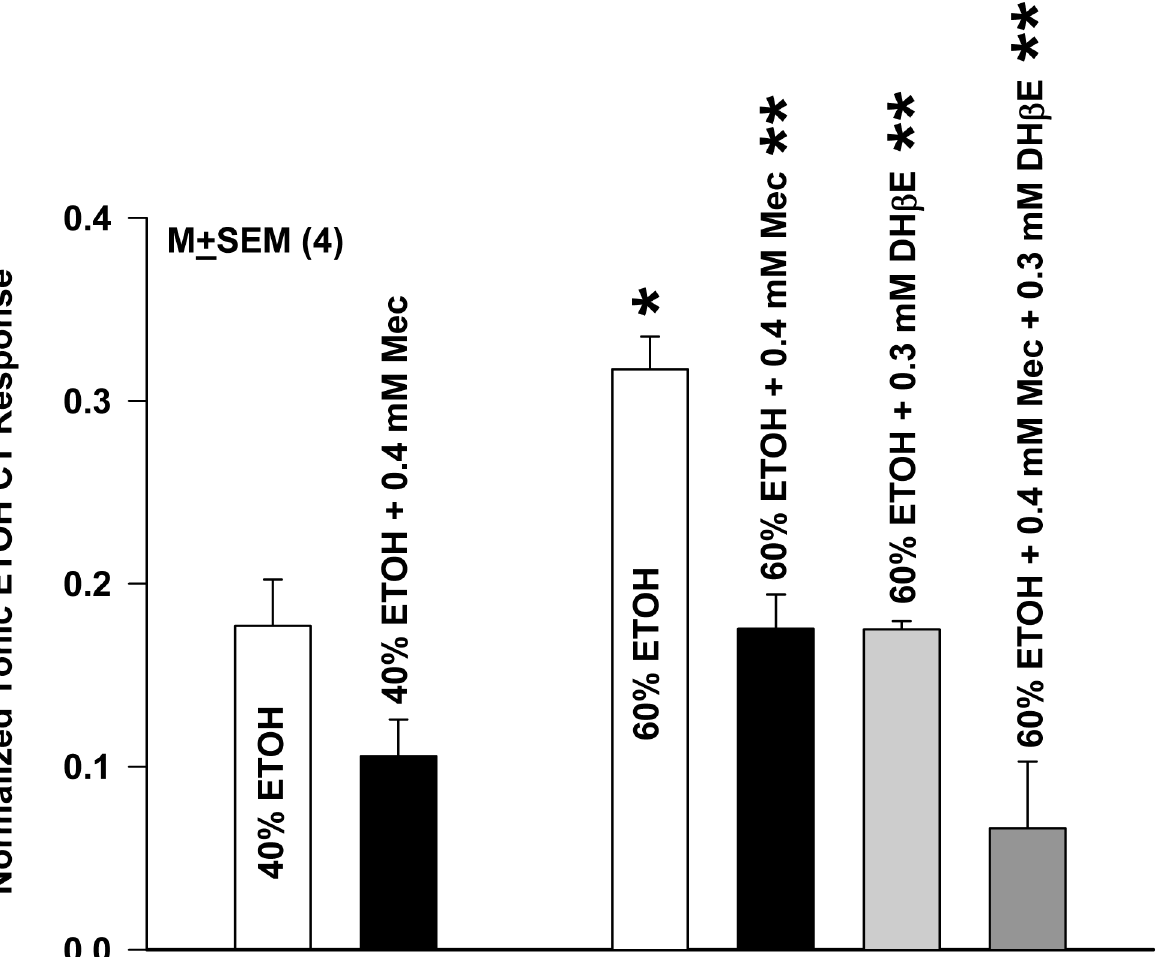
Fig 5. Effect of Mec and DH β E on the rat CT responses to ethanol (ETOH). The mean normalized CT responses ( N = 4) at 40% and 60% ethanol in the presence and absence of 0.4 mM Mec and 0.3 mM DH β E. The mean tonic CT response at 60% ethanol was greater than the CT response at 40% ethanol ( * p = 0.01; unpaired). Relative to 60% ETOH the ** p values in the presence of 0.4 mM Mec, 0.3 mM DH β E, and 0.4 mM Mec + 0.3 mM DH β E were 0.0001, 0.0086, and 0.0002, respectively. Relative to 60% ETOH + 0.4 mM Mec and 60% ETOH + 0.3 mM DH β E, the p value at 60% ETOH + 0.4 mM Mec + 0.3 mM DH β E was 0.03 (unpaired; N = 4).